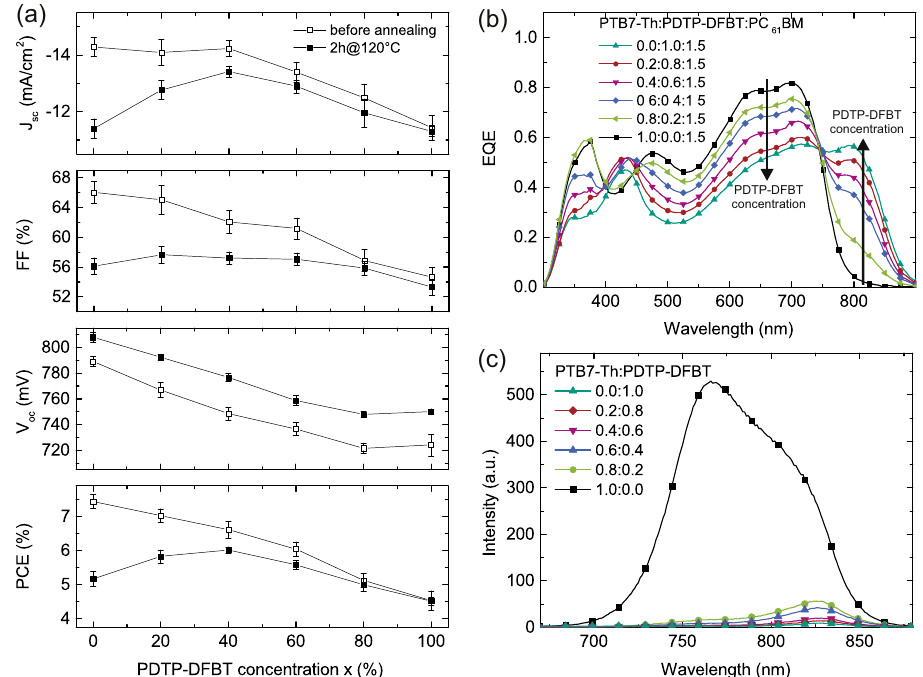
Fig. 3 a Photovoltaic performance of ternary PTB7-Th:PDTP – DFBT:PC 61 BM ([1- x ]: x :1.5 w/w/w) solar cells versus PDTP – DFBT concentration x measured under AM1.5 irradiation before and after annealing (120 °C, 2 h). b Corresponding external quantum ef fi ciencies. c Photoluminescence spectra of binary PTB7-Th:PDTP – DFBT donor blends excited at λ = 610 nm, showing ef fi cient quenching of the PTB7- Th photoluminescence by PDTP –